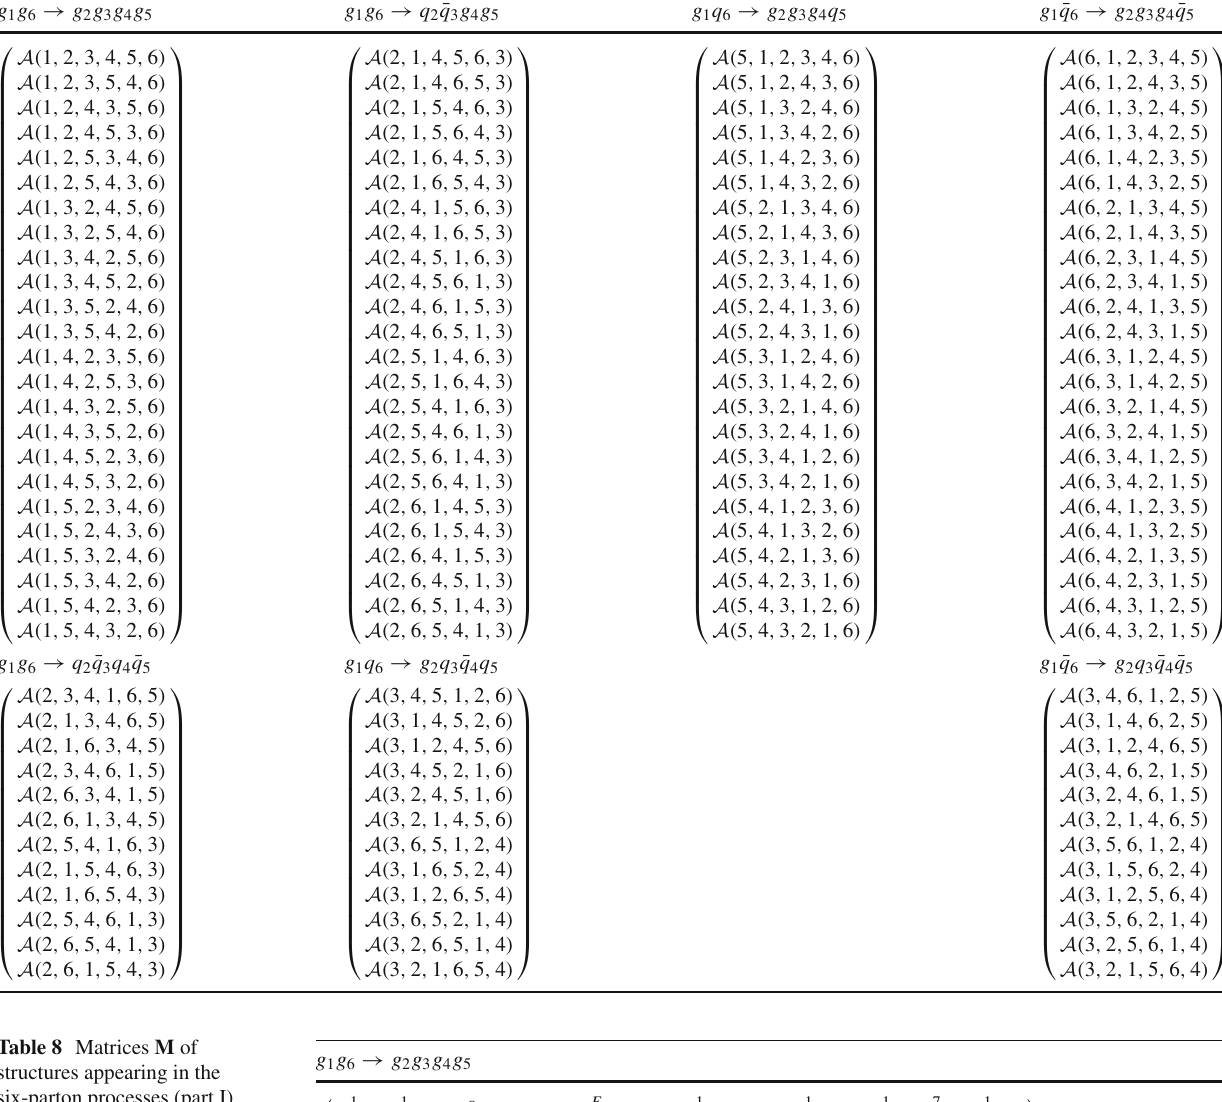
Table 7 Definition of the vector of partial amplitudes (cid:4) A for all six-parton processes. The subscripts in the sub-process indication correspond to the momenta